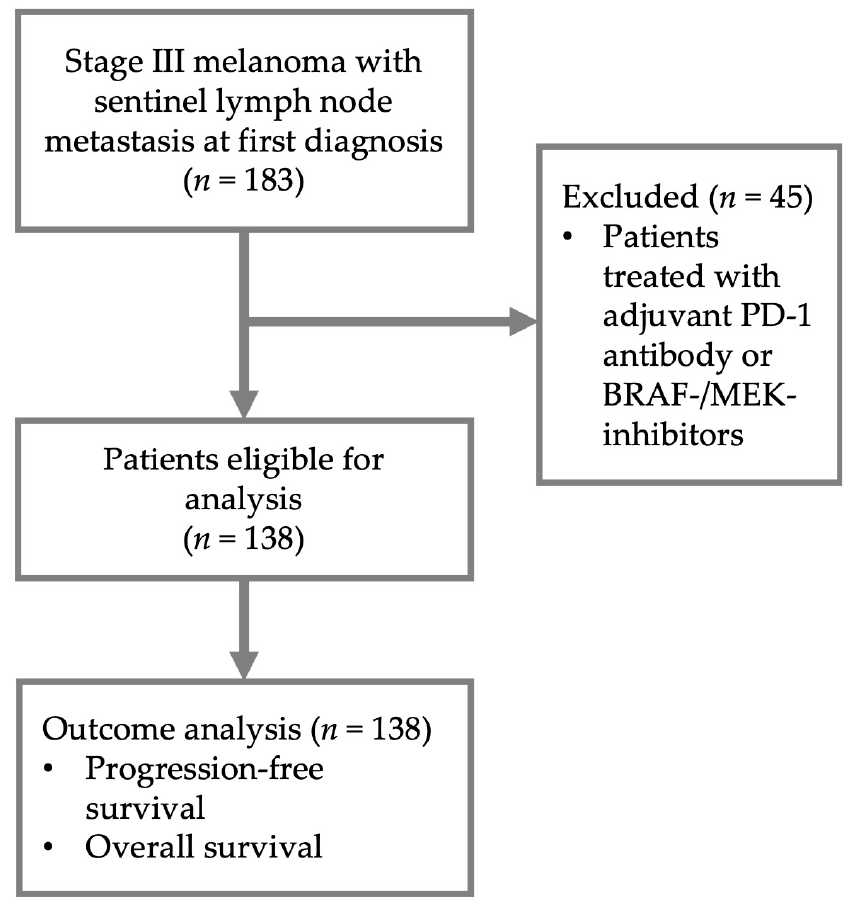
Figure 1. Study flow. 183 patients with stage III melanoma with microscopic sentinel lymph node metastasis were identified at the Department of Dermatology at the University Hospital Cologne. Of these, 138 patients were eligible for